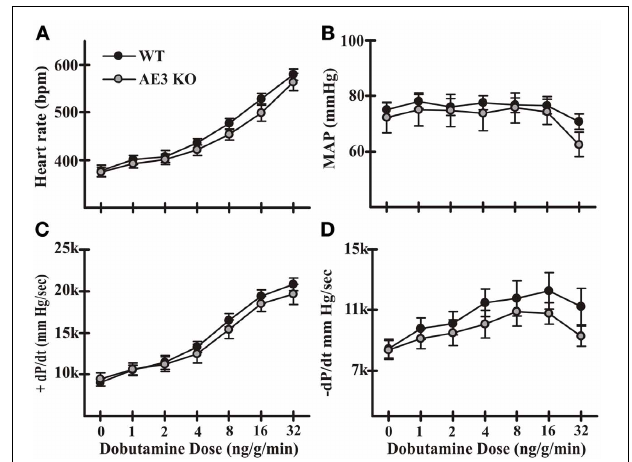
FIGURE 1 | Cardiovascular performance in wild-type and AE3-null mice. Intraventricular and arterial pressures were measured in instrumented anesthetized mice using transducers inserted in the left ventricle and right femoral artery, respectively. Results shown include: (A) heart rate; (B) mean arterial pressure (MAP); (C) + dP/dt; and (D) − dP/dt under both basal conditions and upon β -adrenergic stimulation by infusion of dobutamine via the femoral vein. Values shown are means ± SE, n = 11 for WT, 9 for AE3-null (KO); no significant differences were observed between WT and KO